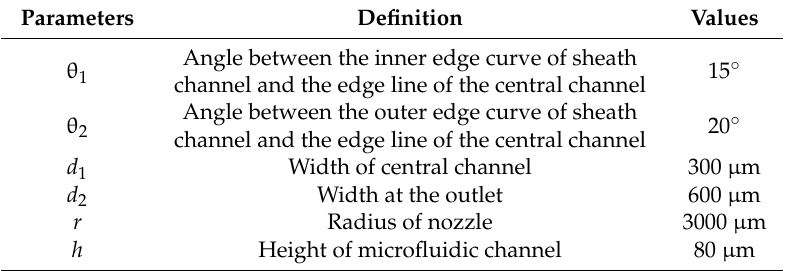
Table 1. Parameters and their specific values of jetting nozzle.